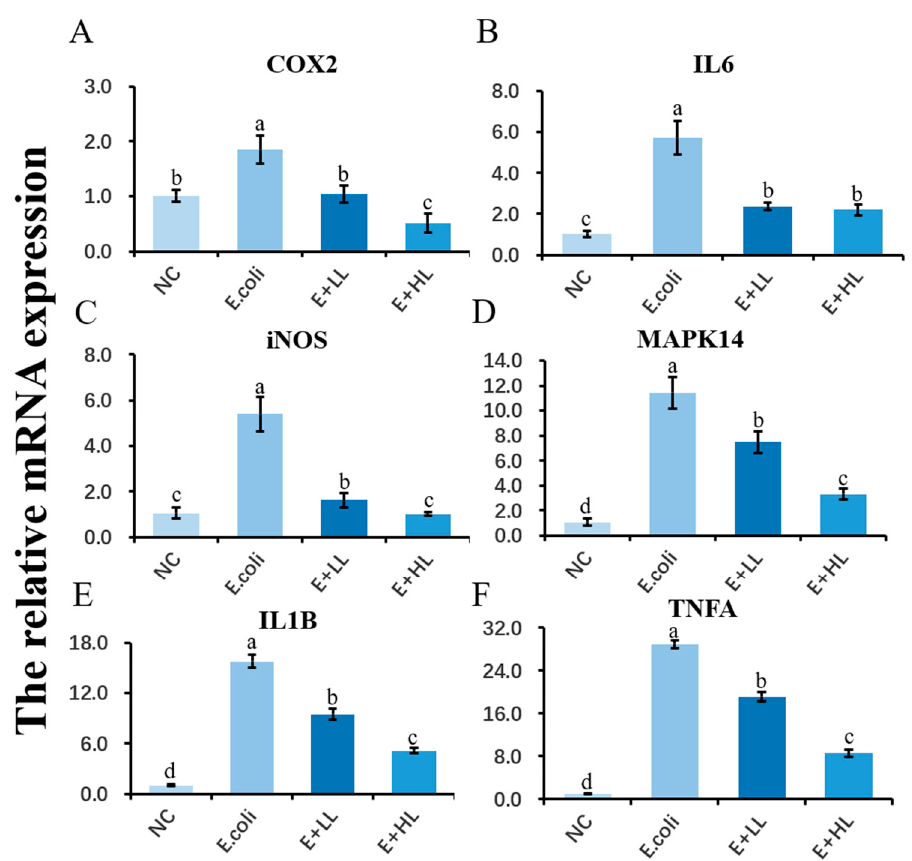
Figure 3. The effect of LBP on mRNA expression related to inflammatory responses. The inflammation injury of pbMEC challenged by E. coli . pbMEC were treated with different doses of LBP at 100 μ g/mL or 300 μ g/mL), followed by a challenge with 1 × 10 7 /mL E. coli for an additional 6 h. ( A ) mRNA quantitative expression of COX2. ( B ) mRNA quantitative expression of IL6. ( C ) mRNA quantitative expression of iNOS. ( D ) mRNA quantitative expression of MAPK14. ( E ) mRNA quantitative expression of IL1B. ( F ) mRNA quantitative expression of TNFA. The biological replicates for PCR running were triplicate, along with three unique experiments. Results are presented as means ± SEM. Superscripts represent that the difference between groups was significant according to statistical analysis ( p < 0.05).